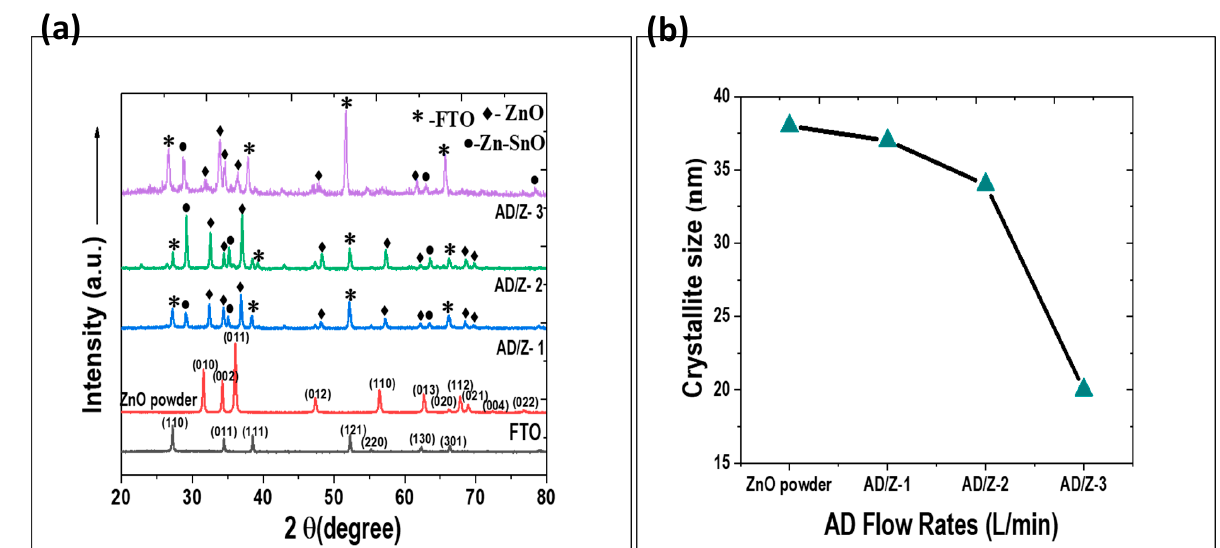
Figure 2. ( a ) XRD pattern, and ( b ) crystallite size that varied with the AD flow rates.